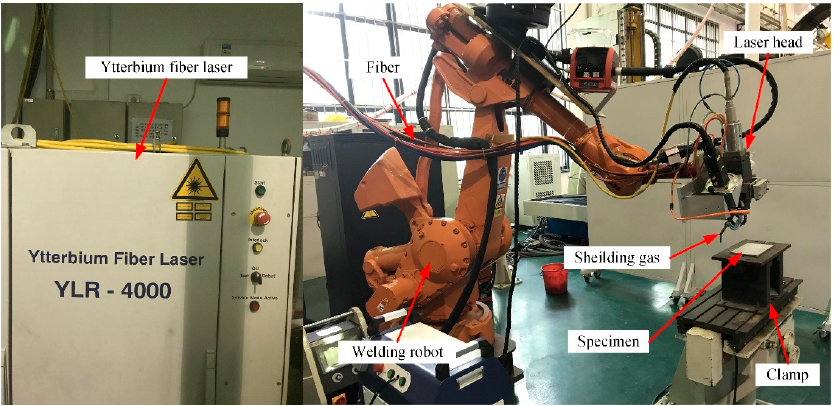
Figure 2. Laser keyhole welding equipment.